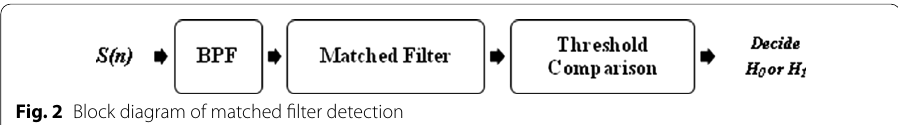
Fig. 2 Block diagram of matched filter